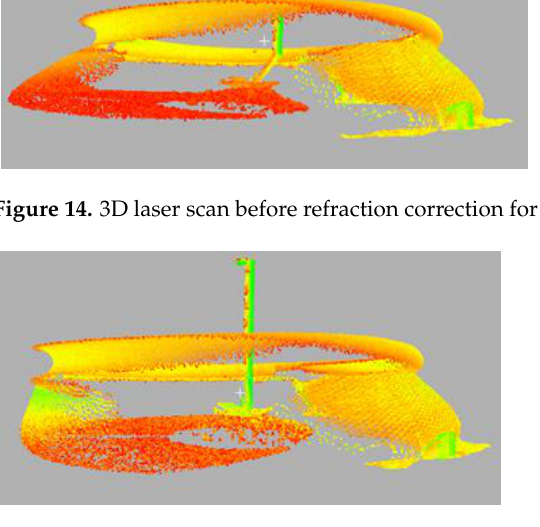
Figure 15. 3 D laser scan after refraction correction for Trial 3 [35,36] (used with permission).